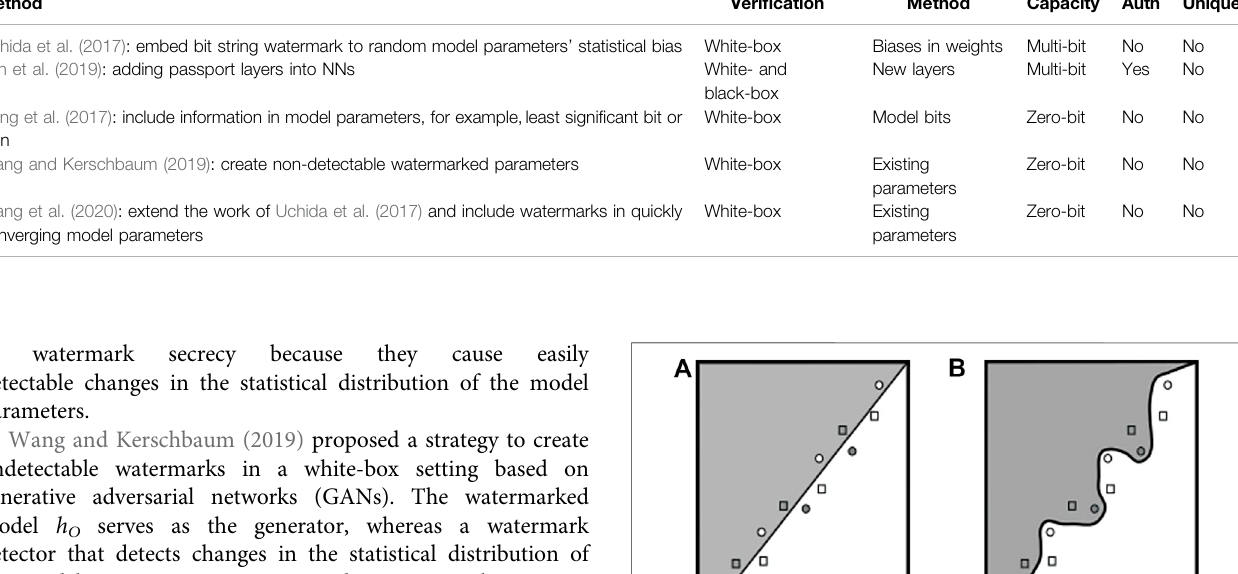
TABLE 2 | Techniques to embed watermarks into model parameters sorted alphabetically by author. Method Veri fi cation